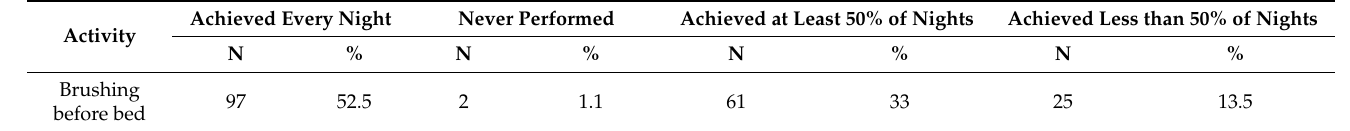
Table 1. Frequency of brushing teeth before